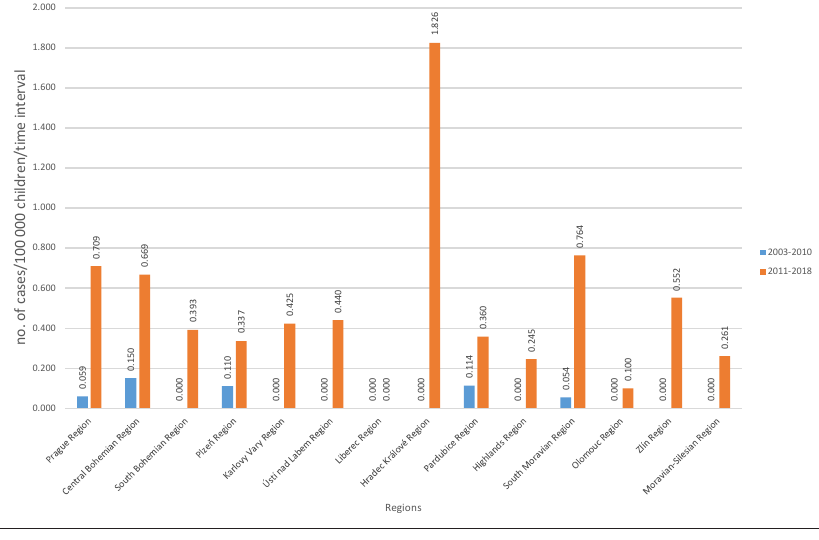
Fig. 2. Number of cases per 100 000 children per time interval per region.